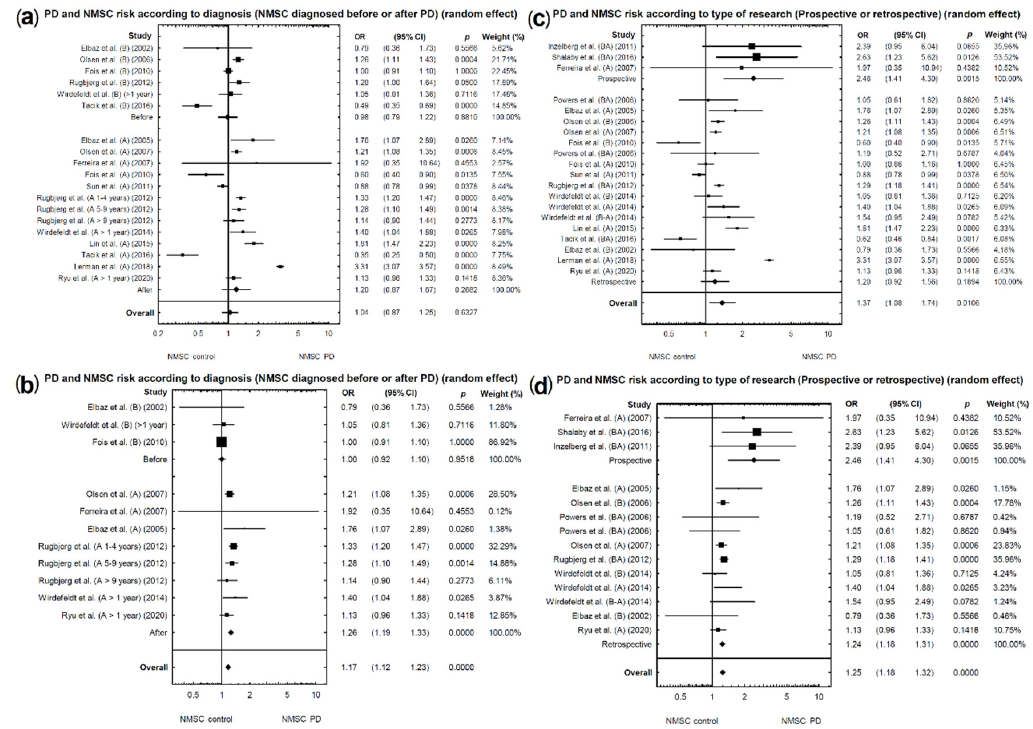
Figure 5. ( a , b ) Forest plot of pooled studies of NMSCs diagnosed before or after incidence of PD in patients: ( a ) all studies; ( b ) studies causing high heterogeneity excluded. ( c , d ) Forest plot of pooled studies of NMSC incidence in PD patients according to the type of study (prospective or retrospective): ( c ) all studies; ( d ) studies causing high heterogeneity excluded. Each line represents an individual study result, with the width of the horizontal line indicating a 95% confidence interval (CI) and the position of the box representing the point estimate OR (odds ratio) (B—NMSCs before PD diagnosis, B-A NMSCs diagnosed ± 1 year before or after PD diagnosis.